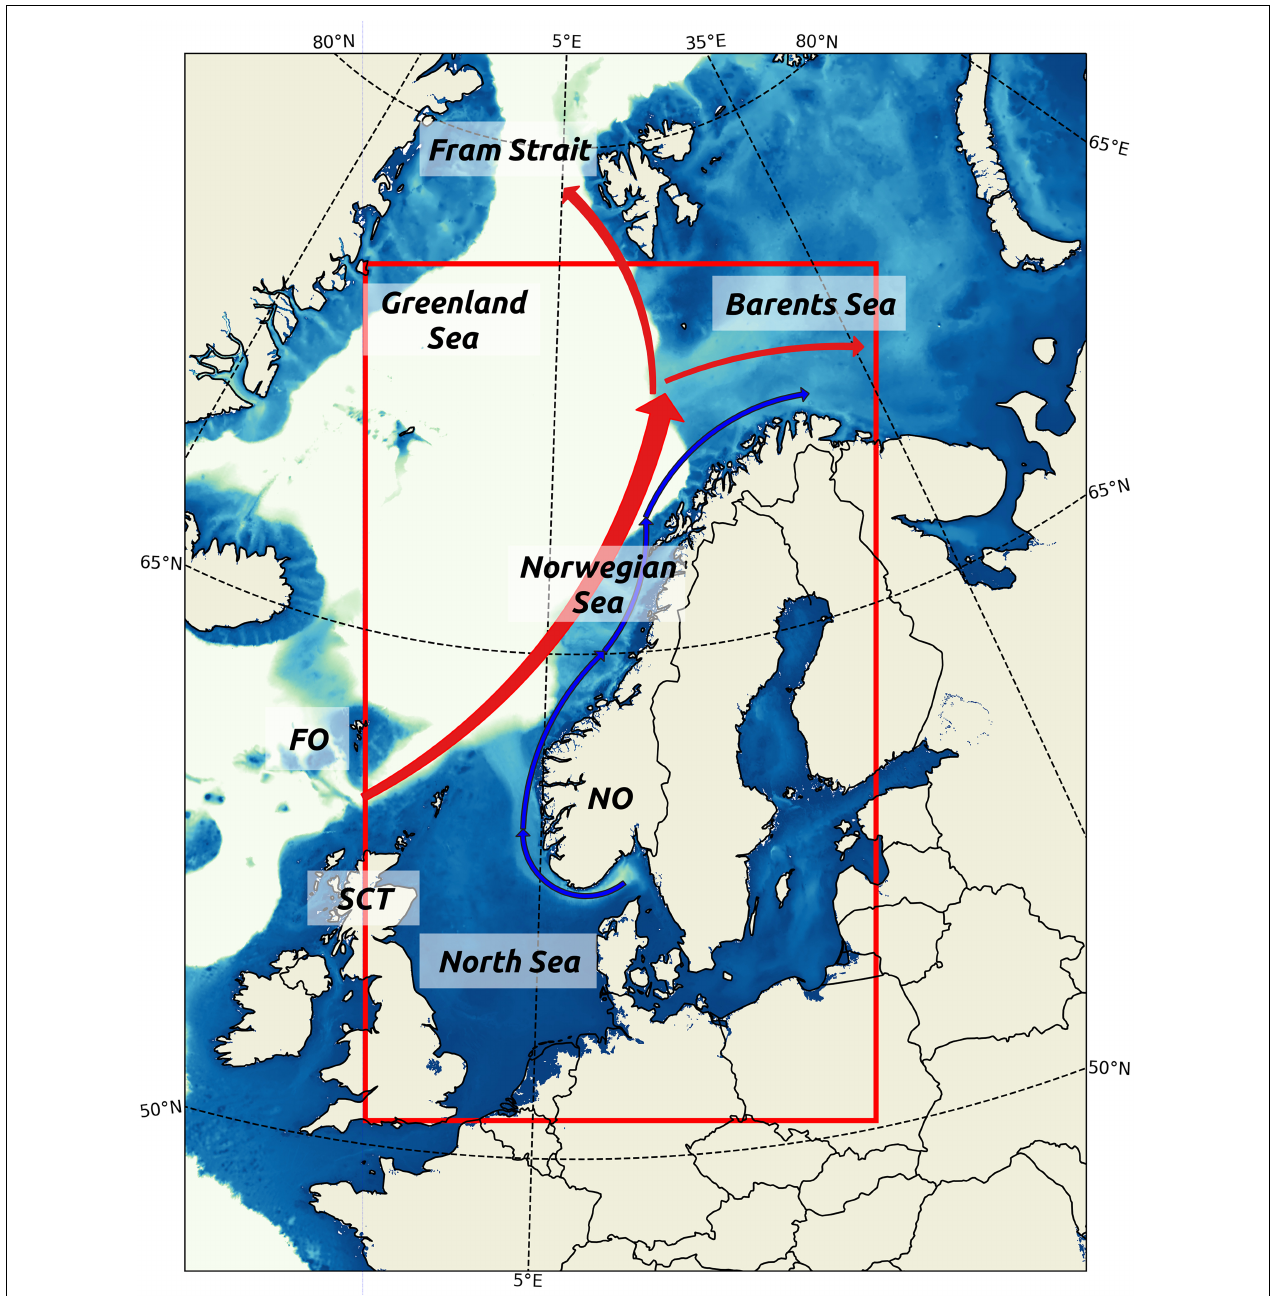
FIGURE 1 | The study region. The red box delimits the area where the blooms phenology is assessed. Red arrow is a coarse representation of the NwAC and blue arrow is the NCC. Abbreviations are Faroe Islands (FO), Norway (NO), and Scotland (SCT).